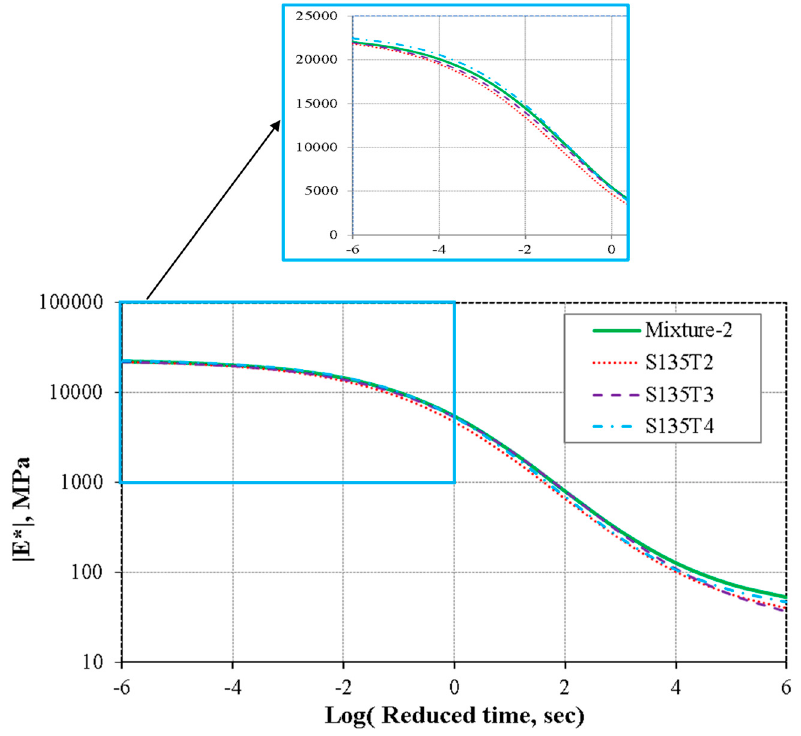
Figure 8. Comparison of master curves for wearing course mixture from the plant (mixture 2).